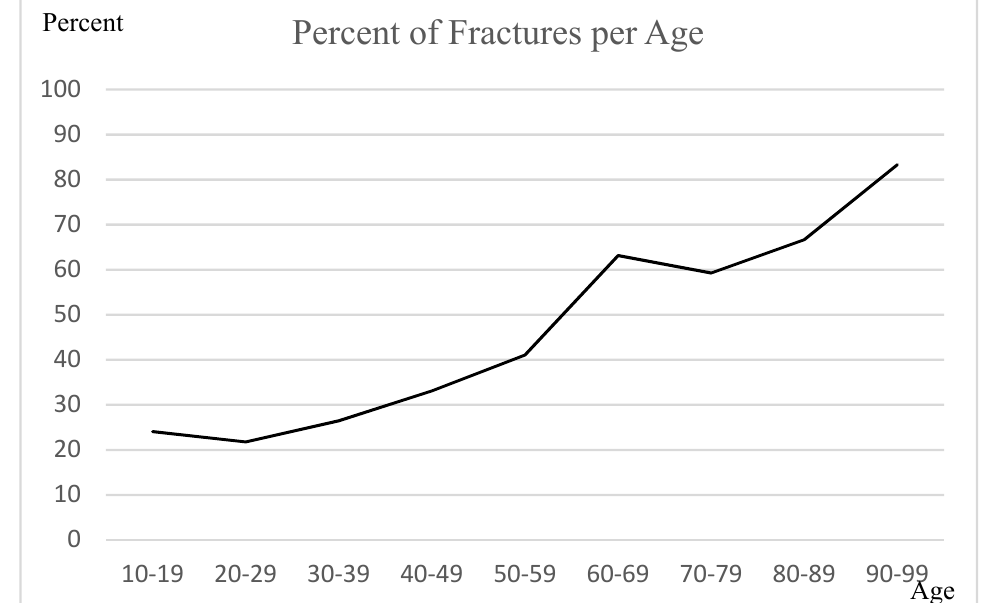
Figure 1. The graph shows the percentage of fractures in groups with increasing age (10-year increments).